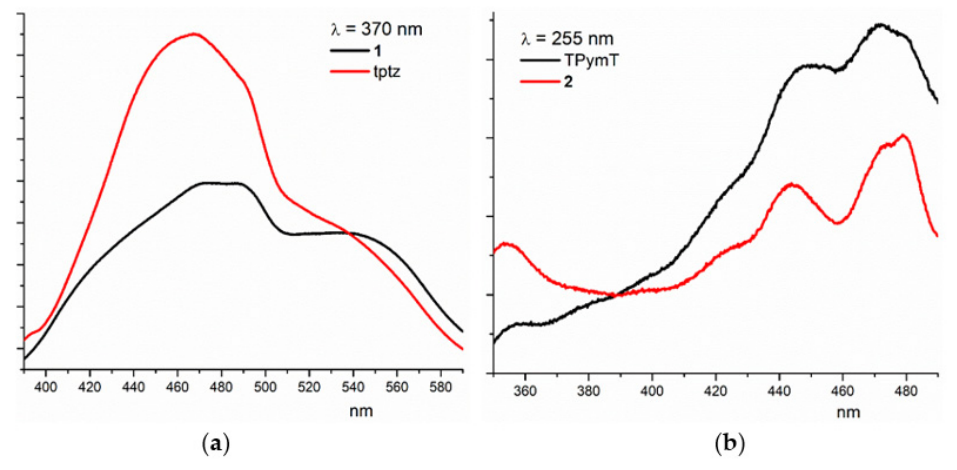
Figure 4. Emission spectra of: ( a ) tptz (red line) and 1 (black line) excited at 370 nm and of ( b ) TPymT (black line) and 2 (red line) at λ exc = 255 nm ( x axis-Wavelength (nm) and y axis - PL intensity).